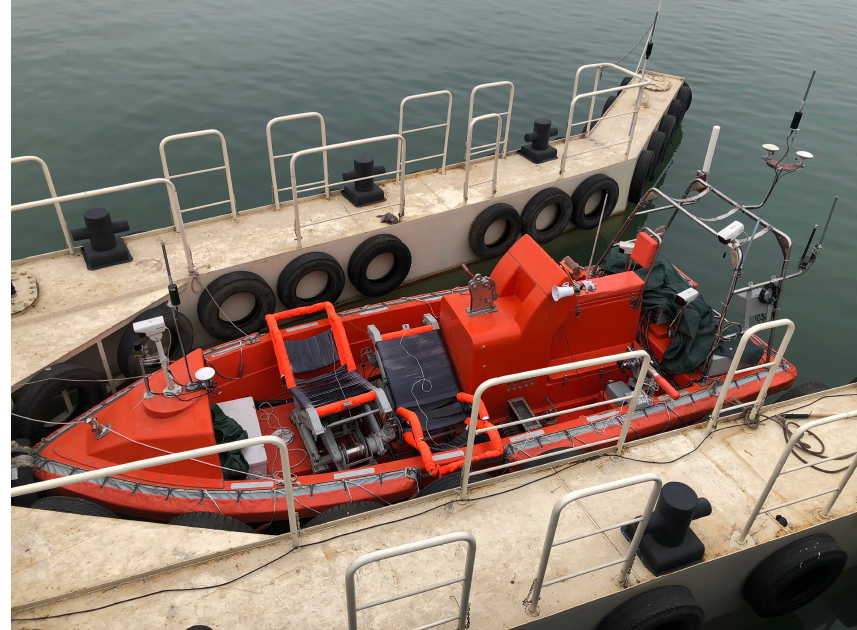
Figure 16. The final result of automatic docking.